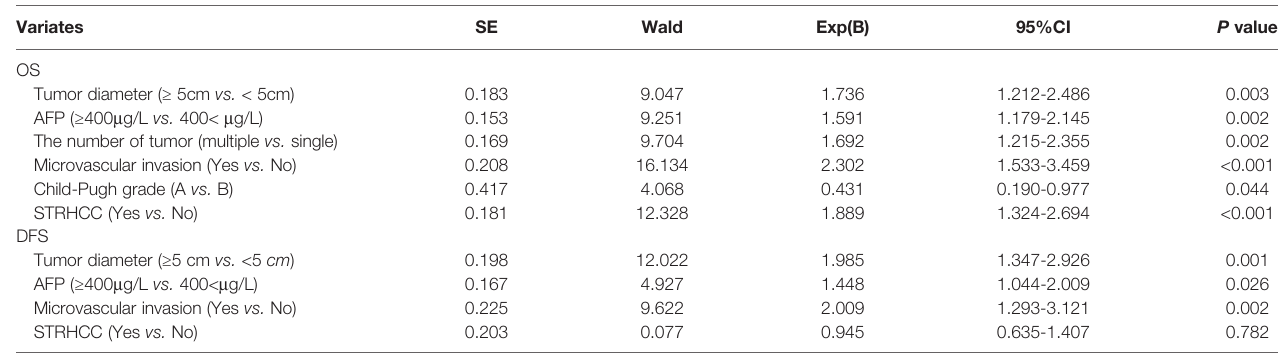
OS, overall survival; DFS, disease-free